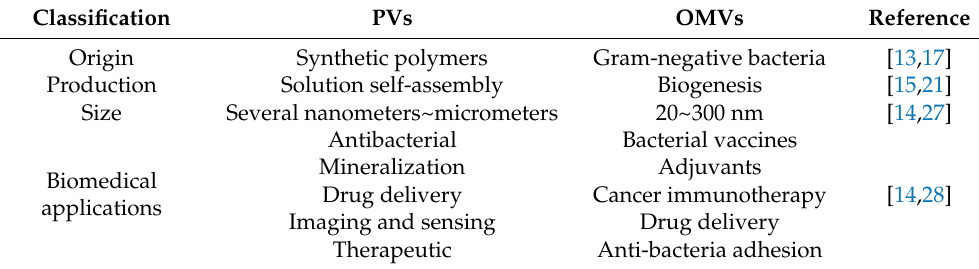
Table 1. Comparison of characteristics of PVs and